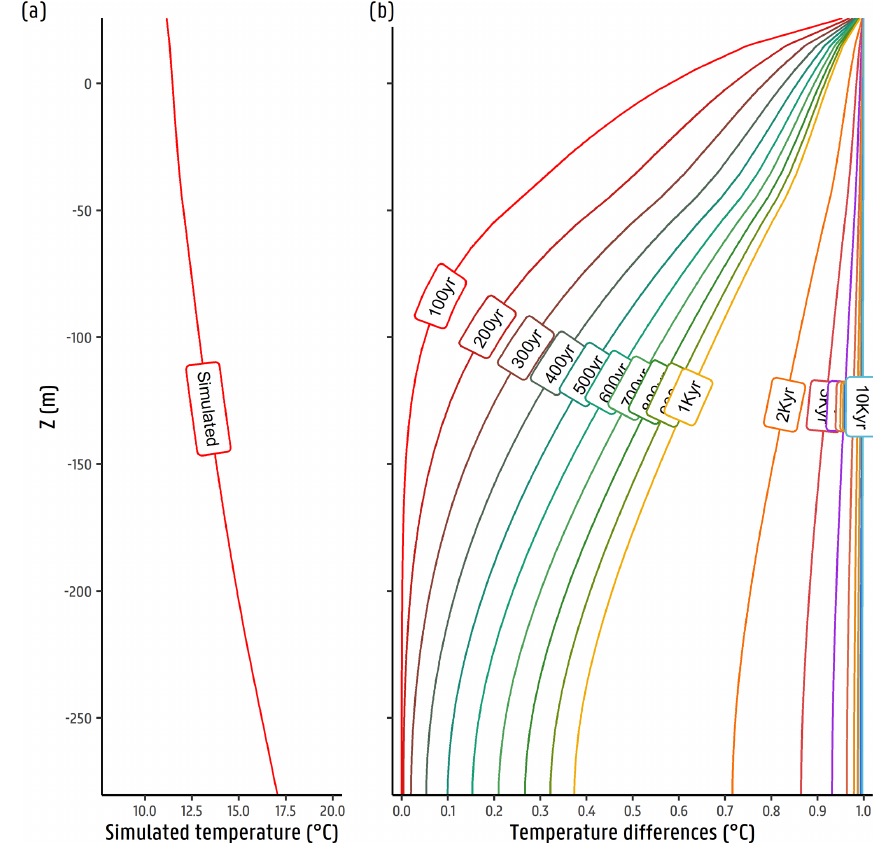
Figure 5. (a) Temperature–depth (TD) profile simulated at observation well (i.e. R-54f) at the end of the coupled groundwater flow and heat transport undisturbed simulation (present time). (b) Temperature difference at the same observation well between the TD profile at the end of each disturbed simulation (present time) minus the undisturbed